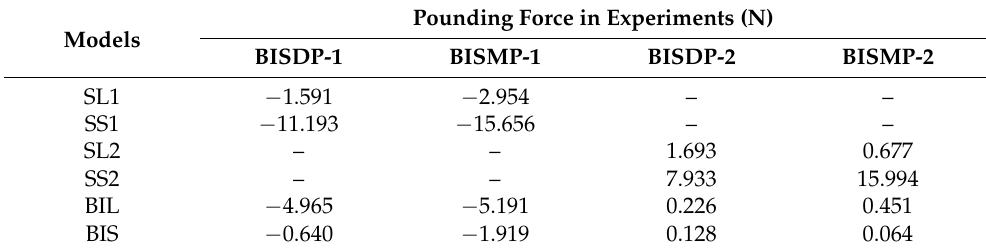
Table 11. The pounding effect between stiffer base-isolated